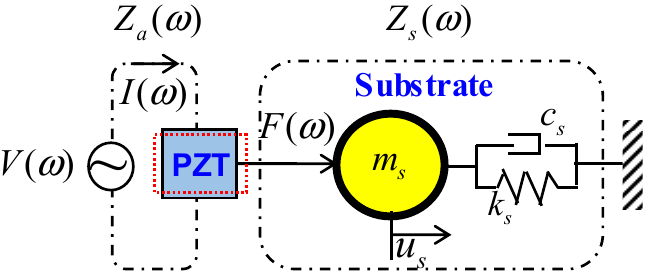
where m s , c s , and k s are the mass, the stiffness, and the damping parameters of the substrate Figure 4. The simplified model of the EMI sensor; the term u s is the displacement of the mass m s structure; and ω is the angular frequency which is often designed in high-frequency In real EMI-based applications, the mechanical impedance of the substrate is not Figure 3. The 1st bending deformation of the EMI sensor due to the piezoelectric effects. bands [46,47]. possible to measure. Instead, we measure the output current I of the system and the EMI response is computed as the rate between the applied voltage V and the current I . Liang et al. [45] demonstrated that the EMI response of the PZT-substrate system, Z( ω ) is a combined function of the structural impedance of the substrate ( Z s ( ω )), and the structural impedance of the PZT patch ( Z a ( ω )) , as follows: